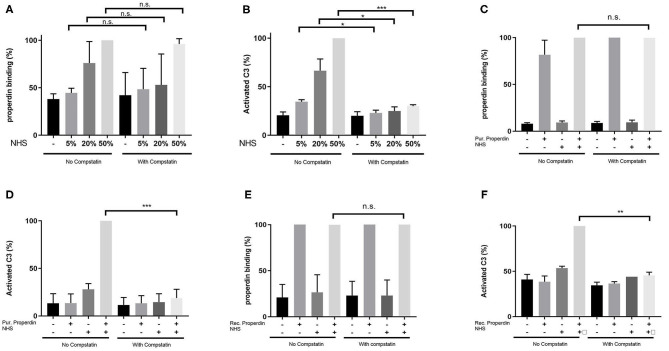
Properdin binding with PTECs in vitro is not mediated via C3b. (A) Properdin binding from serum is not influenced by co-incubation with compstatin. Bars represent a serial dilution of 5, 20, and 50% NHS. (B) C3 complement activation mediated by properdin from serum is completely inhibited by compstatin. (C) Properdin binding purified from plasma is not influenced by compstatin. (D) C3 complement activation by purified properdin is completely inhibited by compstatin. (E) Recombinant properdin binding is not influenced by compstatin. (F) C3 complement activation by recombinant properdin is inhibited by compstatin. All graphs are normalized by the sample without compstatin but with NHS (A,B) or purified properdin with NHS (C,D) or recombinant properdin with NHS (E,F). Data were analyzed by the Mann-Whitney U test with an option of multiple comparison (*P < 0.05, **P < 0.01, ***P < 0.001). Asterisks above the capped lines denote significant differences between the sample without Compstatin but with NHS (A,B) or purified properdin with NHS (C,D) or recombinant properdin with NHS (E,F) and the same sample with Compstatin. N = 6 for all experiments.